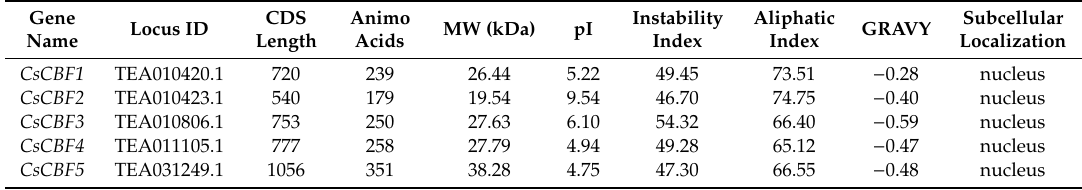
Table 1. Characterization of CsCBFs in tea